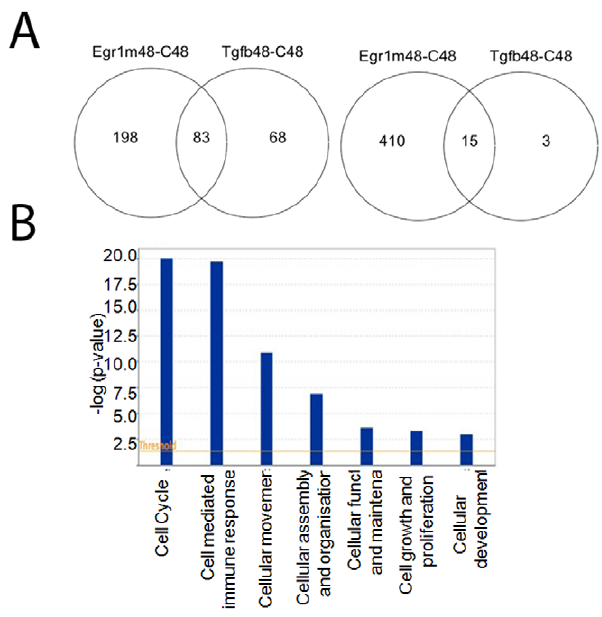
Figure 3. Genes regulated by both TGF-ß and AdEgr-1. Skin fibroblasts were infected with Ad-EGFP or incubated with TGF-ß in parallel for 48 h. Total RNA was subjected to microarray analysis using Illumina chips. A. Venn diagrams of the genes regulated by TGF-ß and Egr-1. Left, up-regulated genes; right, down-regulated genes. B. Ingenuity Pathway Analysis showing canonical signaling pathways enriched with 98 fibroblast genes regulated by both Egr-1 and TGF-ß. The Y axis shows the pathway enrichment.